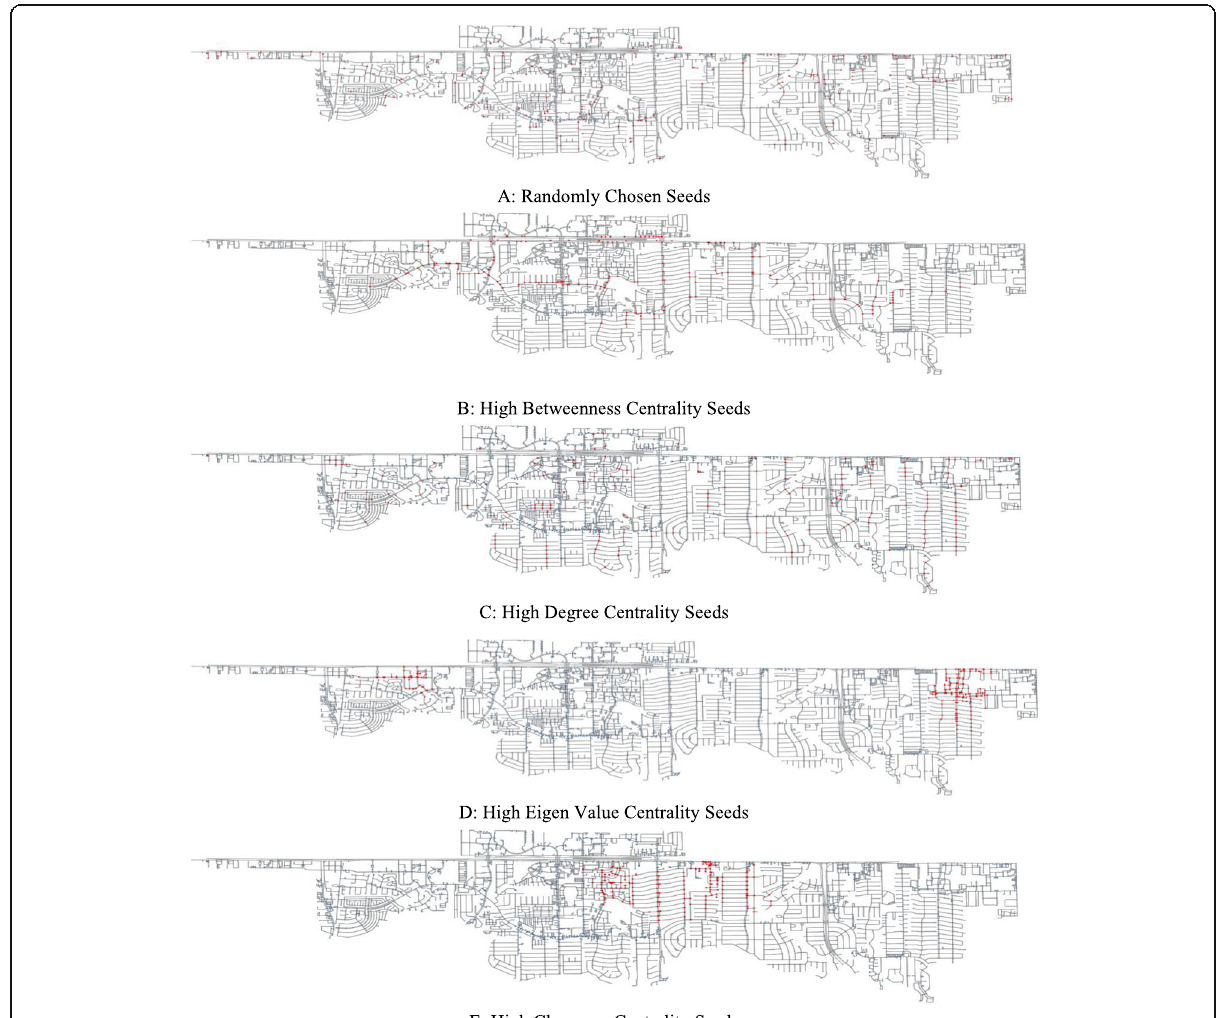
Fig. 6 Locations of Seed Nodes in Road